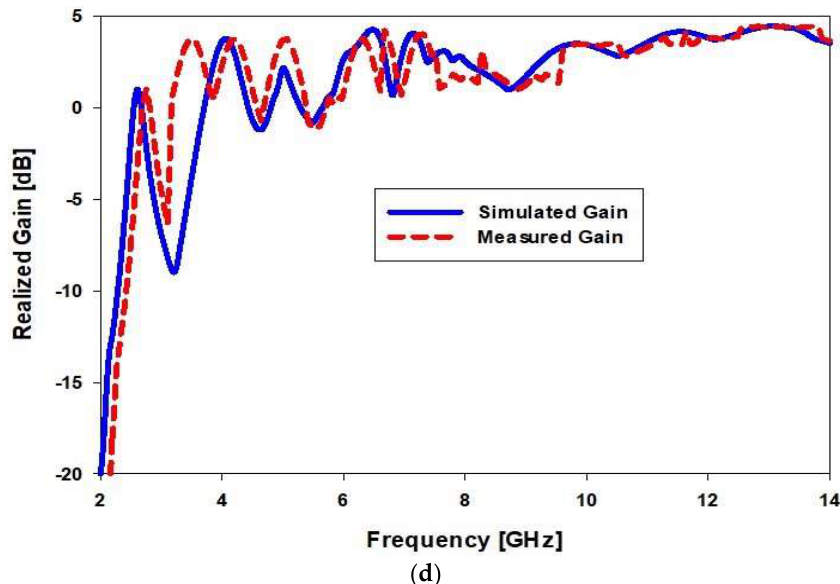
Figure 3. ( a ) The top and bottom layers of the fabricated proposed antenna, ( b ) simulated and mea- sured antenna reflection coefficient, ( c ) proposed antenna design steps, and ( d ) reflection coefficient comparison for the design steps.